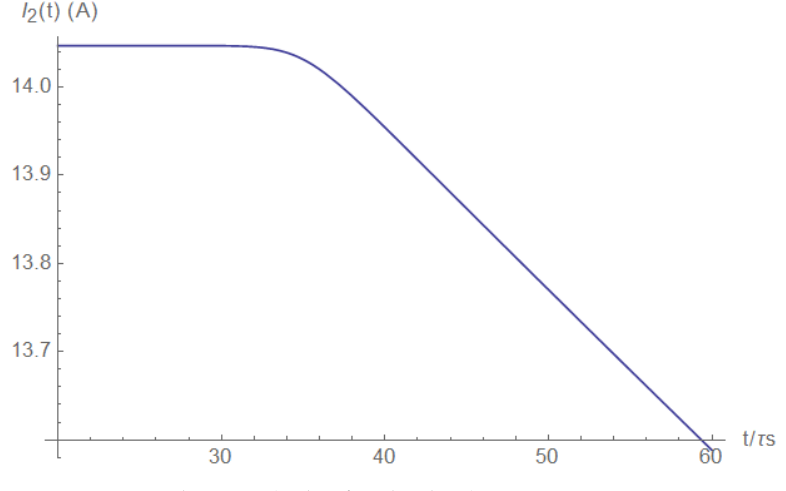
Figure A21. Load current (right after the short).